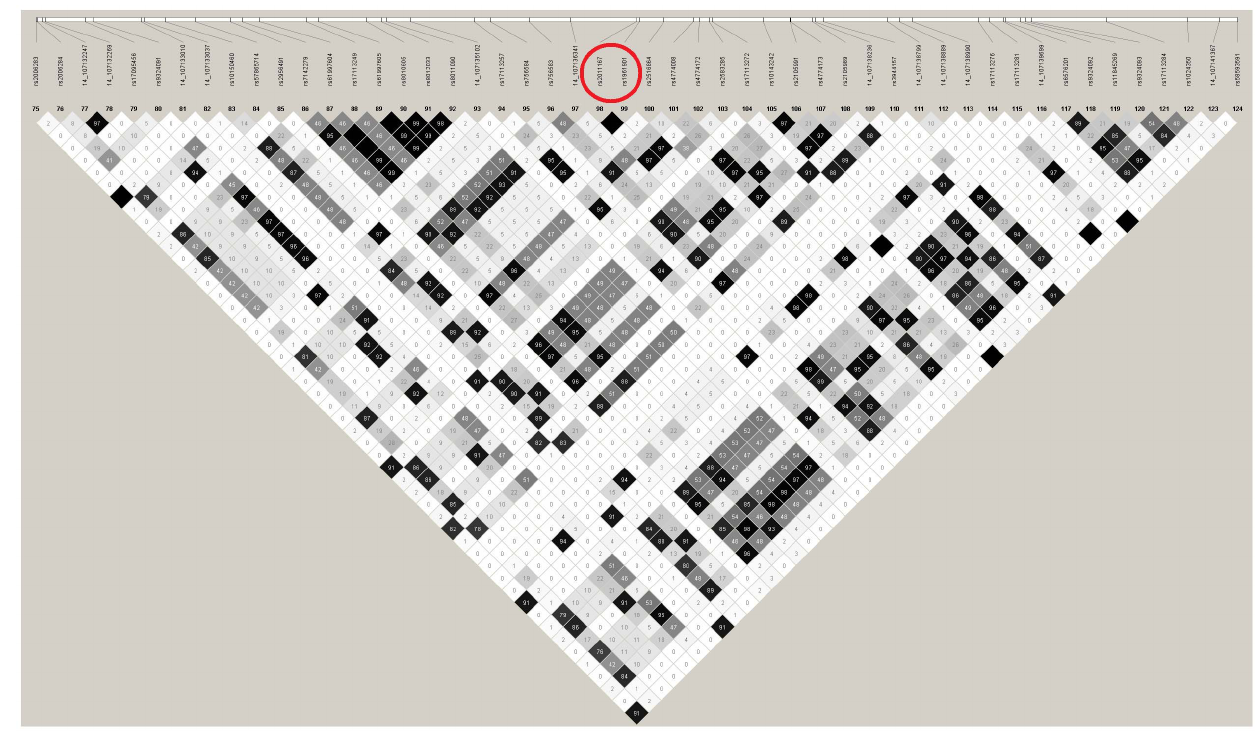
Figure 2. Linkage disequilibrium structure of IGHV1-67 gene ± 5 kb. The SNPs which are significant at 10 2 4 level are circled in red.